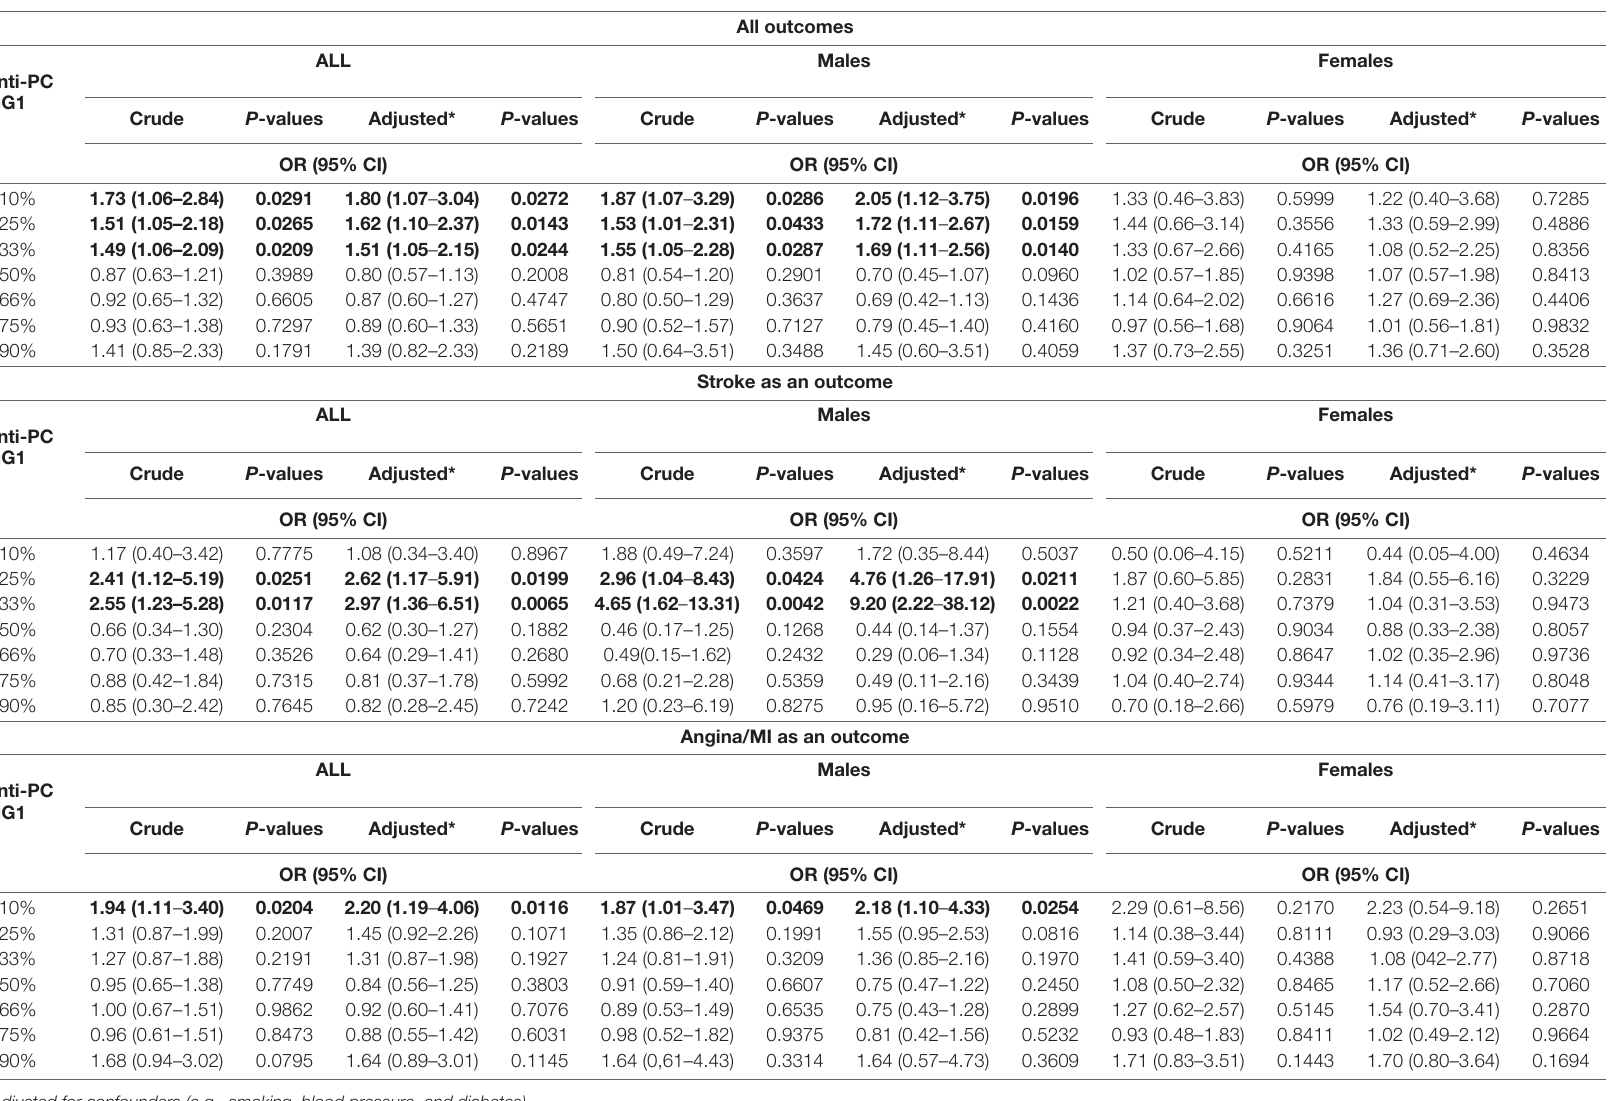
TABLE 3 | Association between levels of IgG1 anti-PC and risk for CVD, stroke, and MI among all participants and men and women.